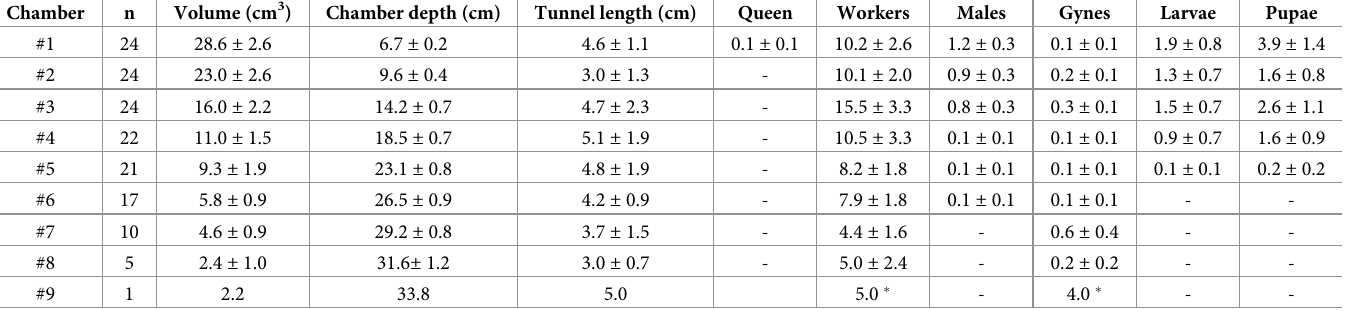
Table 1. Mean ( ± SEM) volume and depth of the chambers, tunnel length, and composition of the population of each chamber according to its relative position for the 24 E . ruidum sp. 2 nests extracted using the paraffin wax technique. � The average values reported for the ninth chamber concerning the number of workers and gynes, must be considered with reservation because only one nest with nine chambers could be cast; they cannot be directly compared to the mean values found in the other